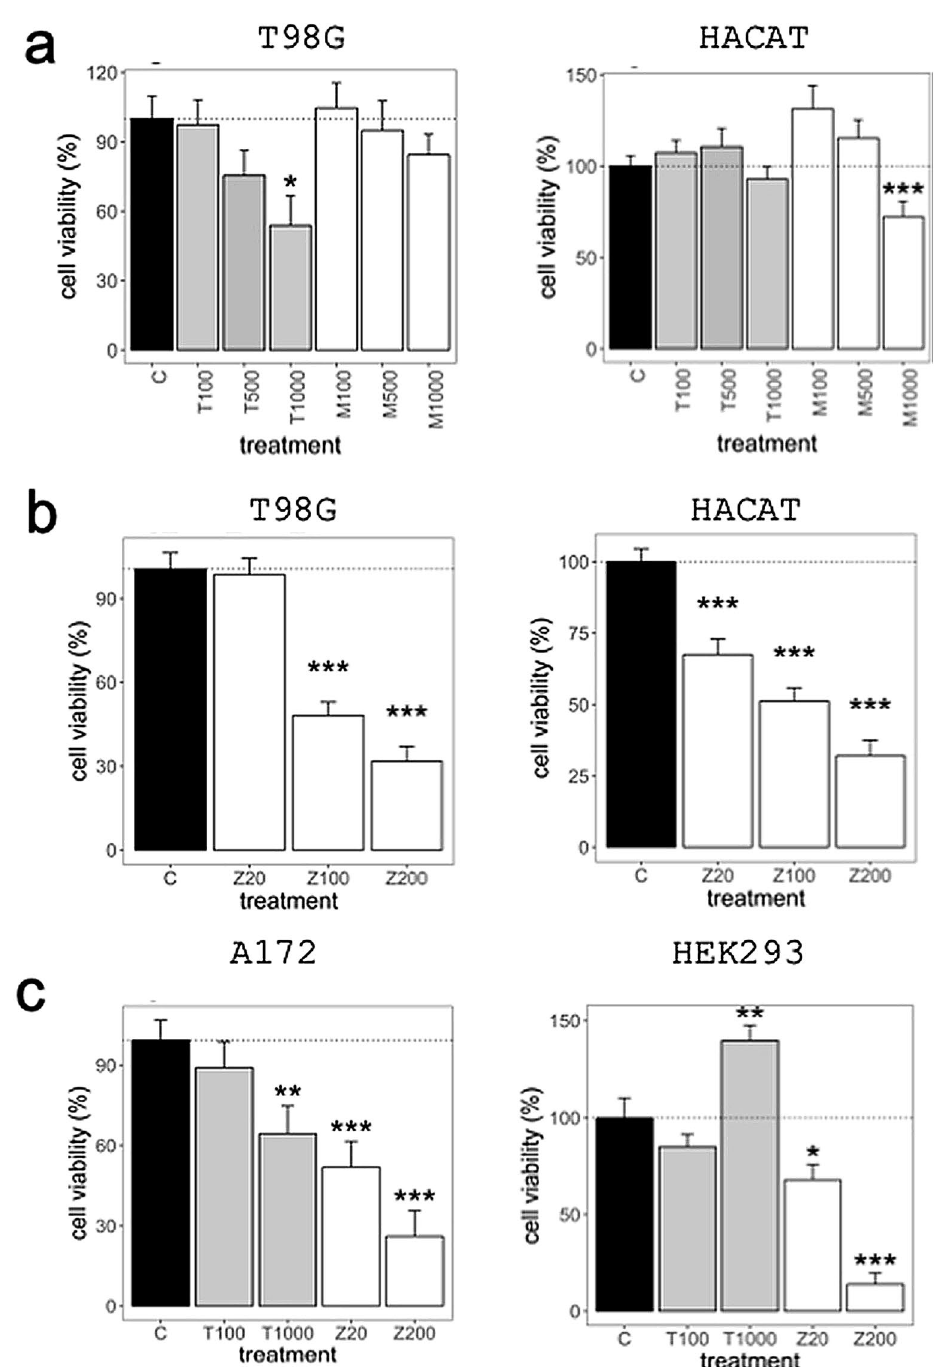
Figure 2. Cell viability assay. ( a ) Cytotoxicity in T98G cell line (left) and HACAT non-cancerous cell line (right) following 72 h treatment with Tip and Middle extracts from the same DAV. ( b ) Dose-dependent representation for T98G (left) and HACAT (right) cell lines following 72 h treatment with TMZ. ( c ) Cytotoxicity in A172 (left) and HEK293 (right) cell lines following 72 h treatment with DAV extract and TMZ. Values are shown in μg/mL. T tip portion, M middle portion, Z TMZ. Linear mixed models to assess the effects of treatments were used. Data are means ± standard error of the mean (SEM) (n = 3). P -value of the significant pairwise comparison against control ( + P = 0.1–0.05, * P = 0.05–0.01, ** P = 0.01–0.001, *** P ≤